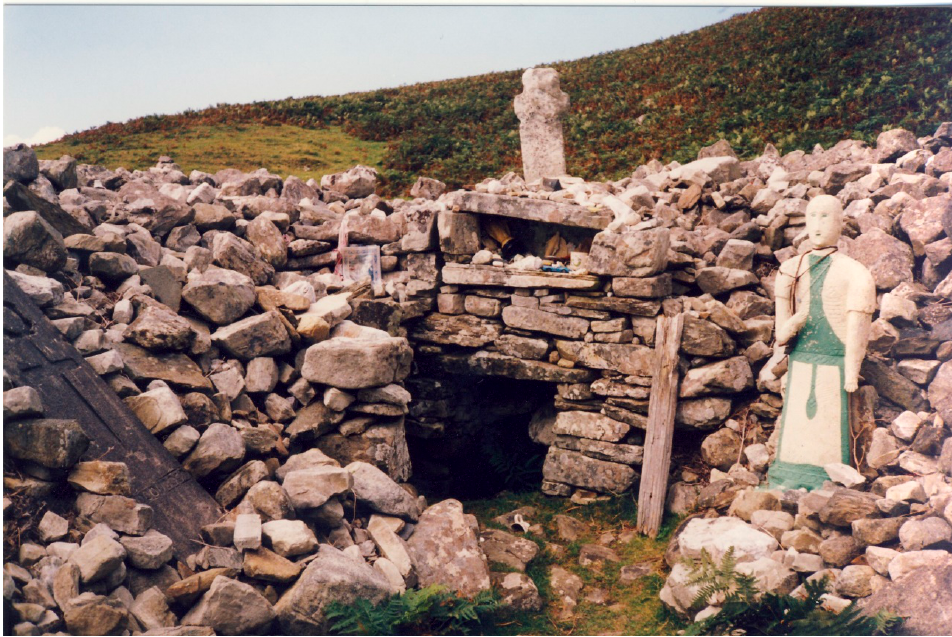
Figure 7. St. Columcille’s Well, Glencolumcille.